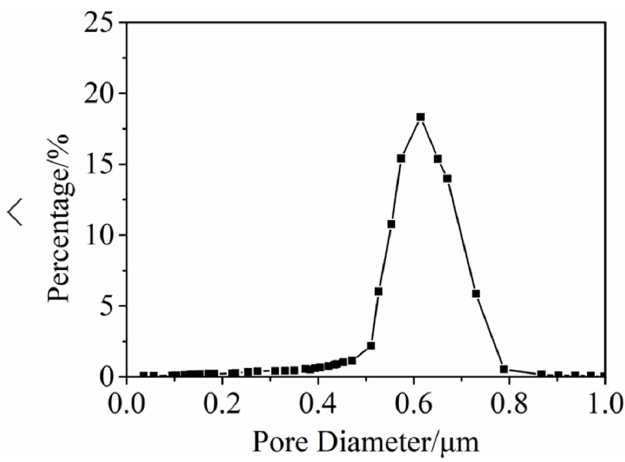
Figure 15. Janus–CA fiber membrane pore size distribution curve.